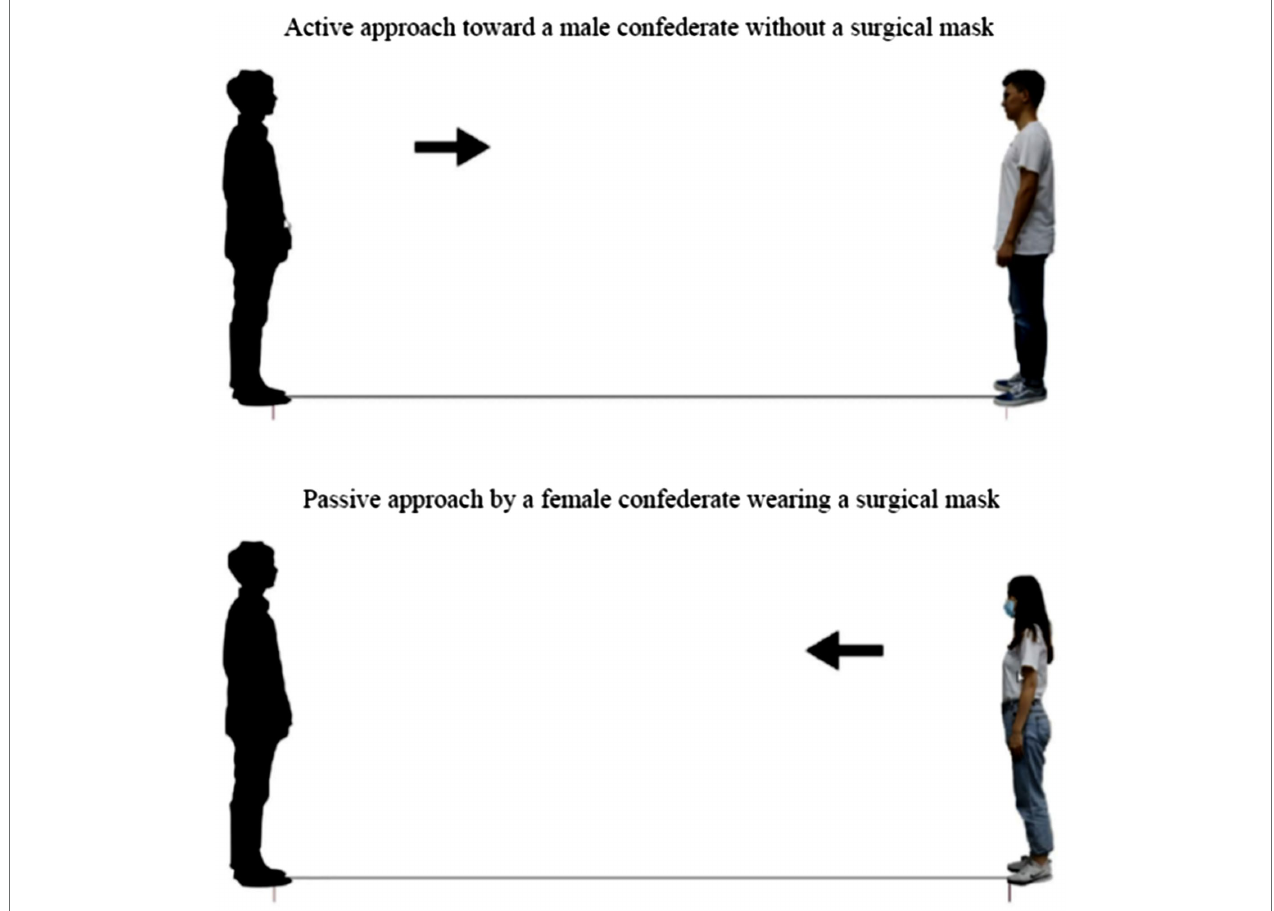
FIGURE 1 | Screenshots of the online survey under various